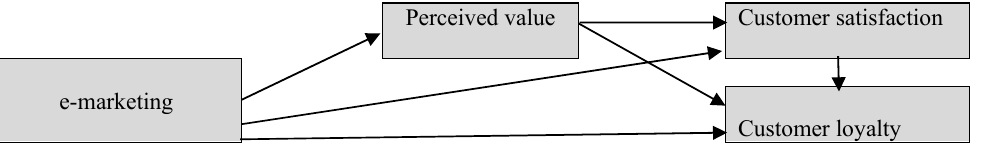
Fig. 1. Research Conceptual